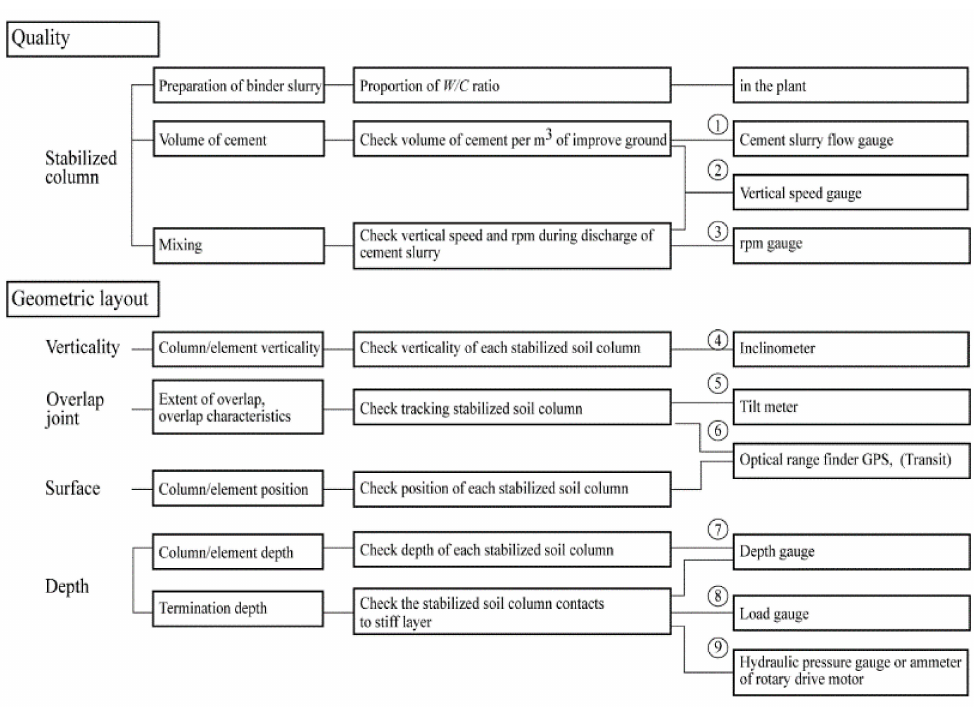
Figure 5. Operation monitoring for the CDM method on land works (after